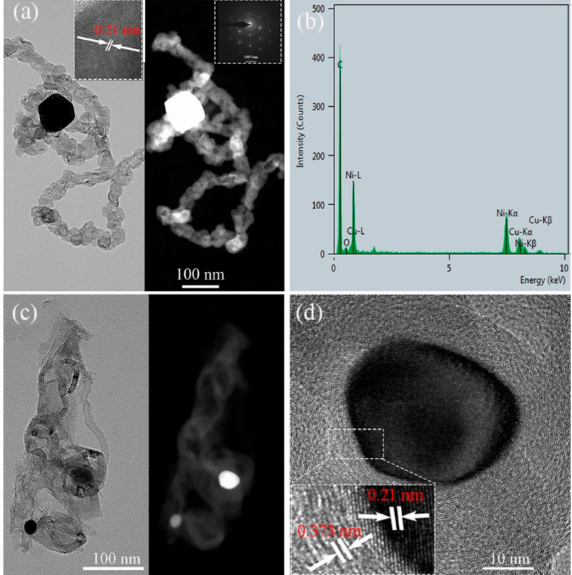
Figure 12. TEM bright- / dark-field images and SAED (inset) of samples: ( a ) Hollow CNTs and ( b ) EDS pattern, ( c ) bamboo-like CNTs, and ( d ) HRTEM image.